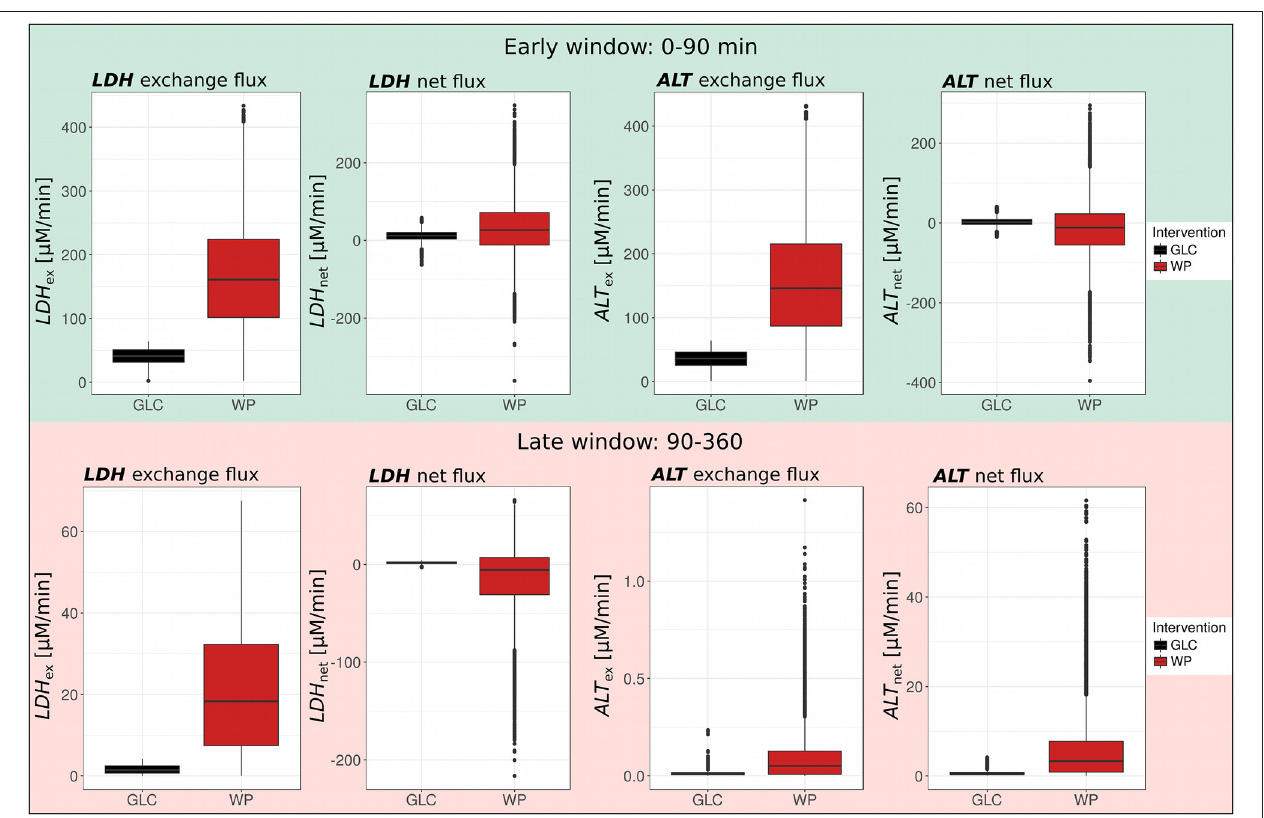
FIGURE 5 | LDH and ALT exchange and net fluxes. Boxplots of LDH and ALT exchange and net fluxes in GLC and WP obtained for the early (0–90min) and late (90–360min) postprandial phase (GLC, black; WP, red; n = 10,000).